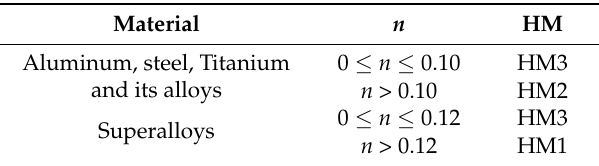
Table 4. Classification according to n